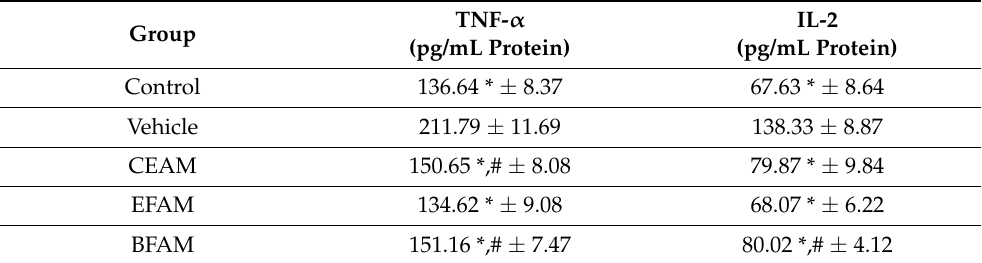
Table 4. Effect of the A. maurorum extract (CEAM), ethyl acetate (EFAM), and butanol